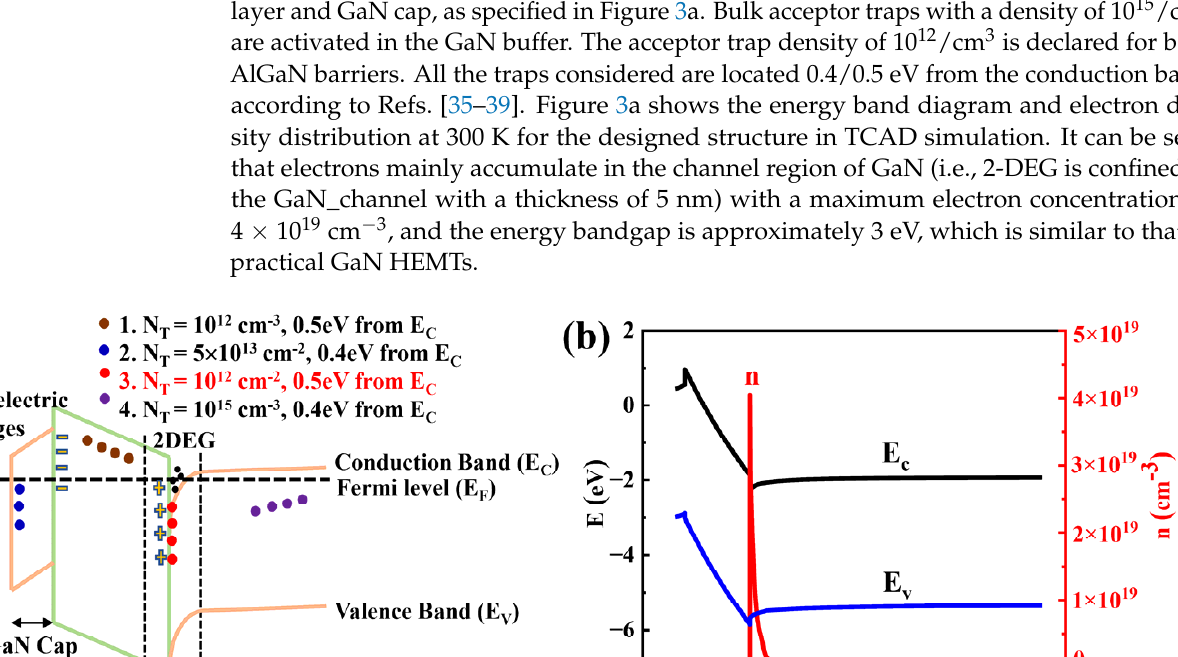
Figure 4. ( a ) DC characteristics of GaN HEMTs and ( b ) transfer and transconductance characteris ‐ tics of GaN HEMTs.